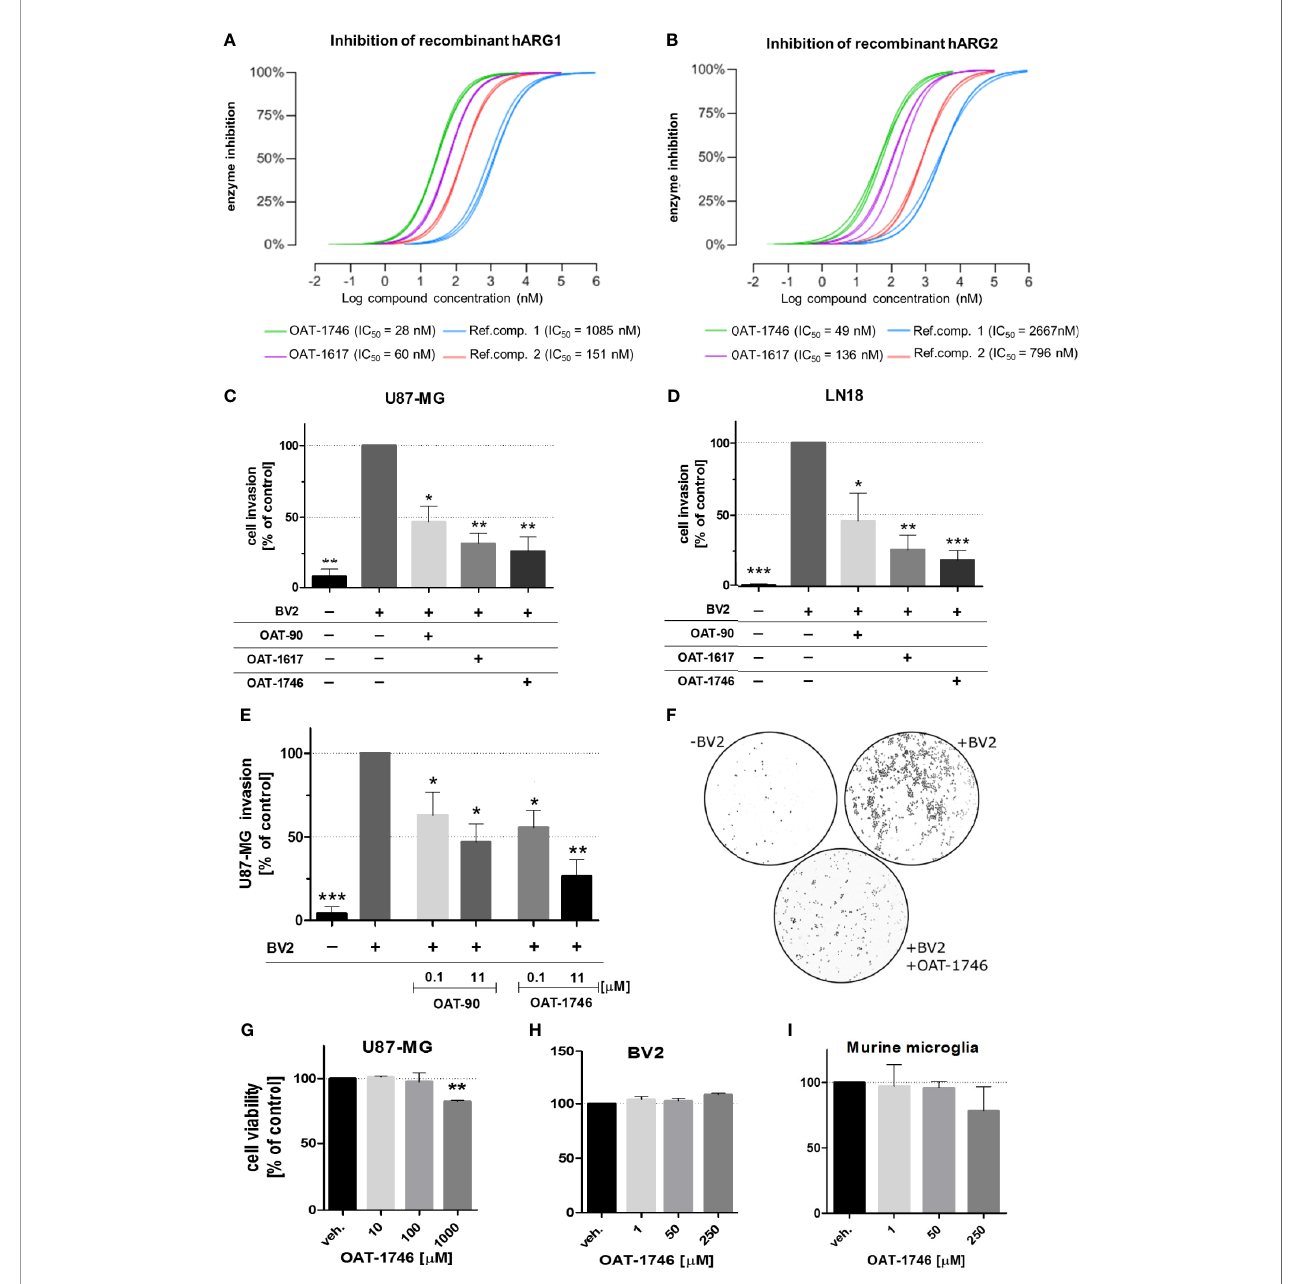
FIGURE 2 | The effect of OAT inhibitors on human arginase 1/2 activity and microglia-induced glioma invasion. (A, B) . The activity of two new and two reference ARG inhibitors was tested towards recombinant human ARG1 and ARG2 (hARG1 and hARG2, respectively) The IC values were determined. (C, D) Graphs represent relative invasion of (C) U87-MG or (D) LN18 cells induced by the co-culture with murine microglial cells (BV2). Tumor invasion was determined using a Matrigel matrix assay. Invasion of glioma cells co-cultured with BV2 cells is set as 100%. Three tested inhibitors (OAT-90, OAT-1617, OAT-1746) were used at 11 µM concentration and all of them effectively reduced glioma invasion. Data are expressed relatively to a basal invasion in the absence of microglial cells. (E) The effects of OAT-90 and the second generation inhibitor OAT-1746 applied at 0.1 and 11 µM concentration on microglia induced invasion of U87-MG cells. Data are presented as means ± S.D and were calculated from three independent biological experiments. Statistical signi fi cance was evaluated using one-sample t-test. (F) The representative images of DAPI-stained U87-MG glioma cells on inserts show the nuclei of invading cells in the presence or absence of BV2, and OAT-1746. (G, I) The effect of OAT-1746 on cell viability was determined using MTT metabolism test. Cells were incubated for 24 h with or without OAT-1746 at given concentrations. The in fl uence of OAT-1746 on the viability of (G) U87-MG human glioma cells, (H) BV2 microglial cells and (I) primary murine microglia was determined. Data are presented as means ± S.D (n=3 independent biological experiments). Signi fi cance of differences between the treatments was evaluated using one-way ANOVA followed by Dunnett ’ s post-hoc test, p-Values were considered as signi fi cant when ***p < 0.001; **p < 0.01; *p <